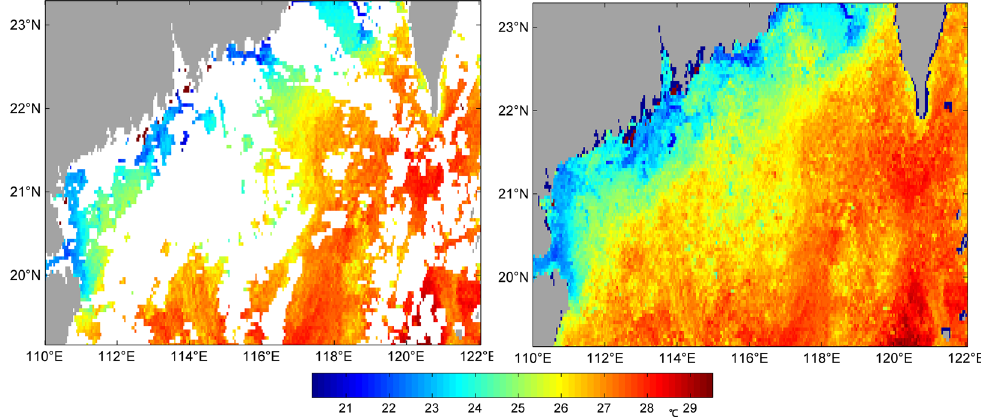
Fig 4. Left panel: original gappy image for 12 th April, 2012; right panel: its reconstruction image.